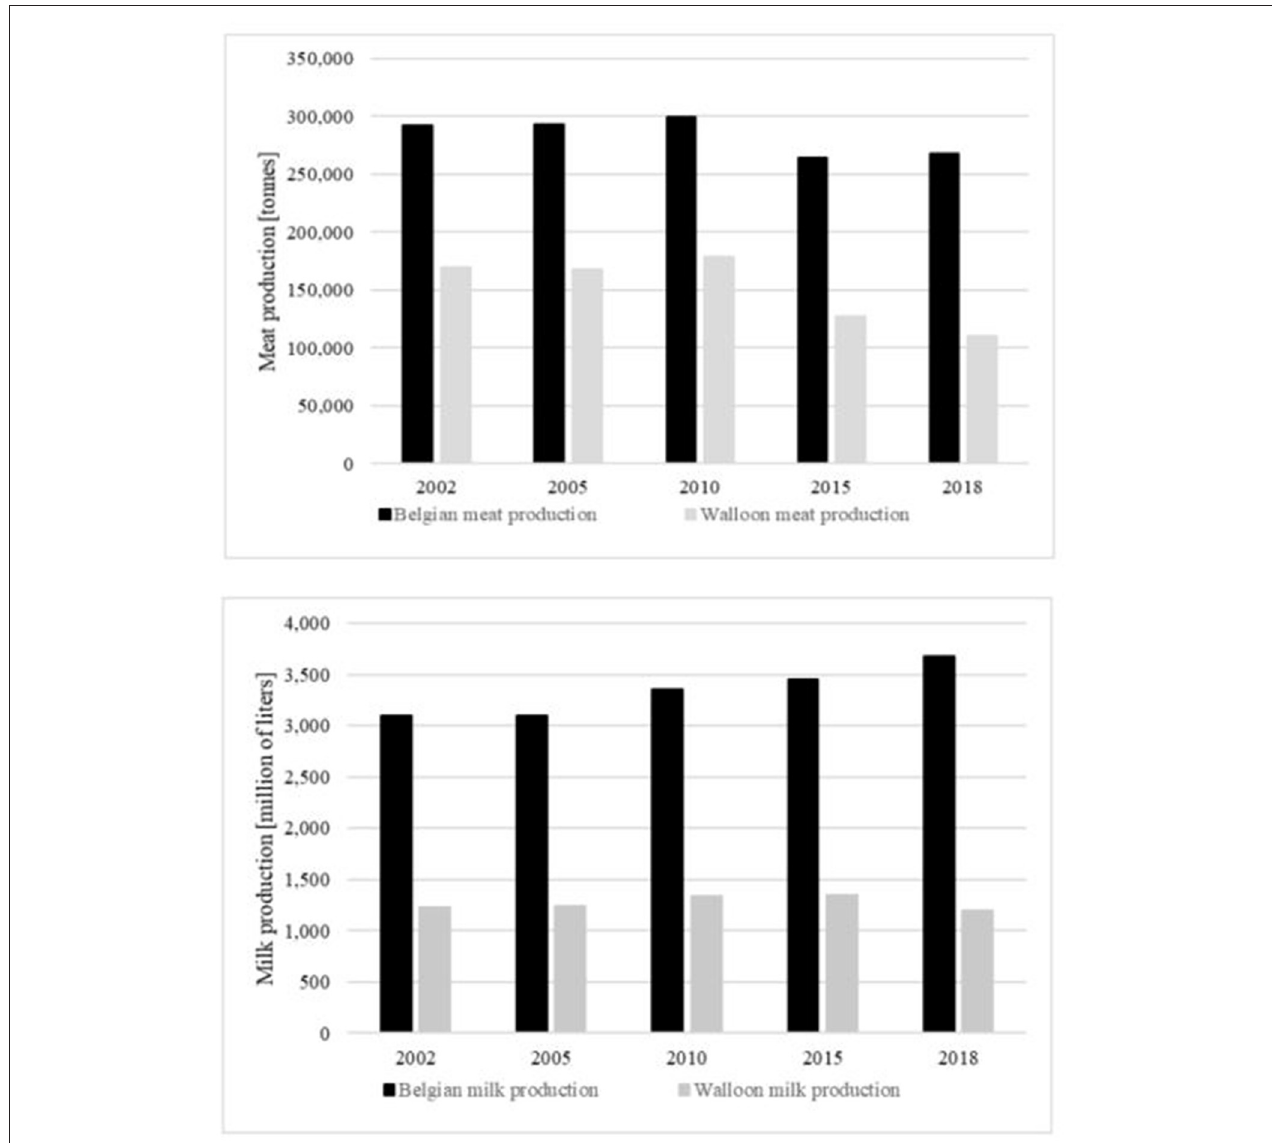
FIGURE 2 | Milk and meat production in Belgium and Wallonia (SPW). The most common breeds within the Walloon dairy sector are the Freisen-Holstein (89%), the Bleues mixtes (4%), the Montbéliardes (2%), the Rouge Pie de l’Est (1%), the Normandes (1%) and other breeds (4%) (La Spina, 2017), while the dominant breed in the beef sector is the double-muscled Belgian Blue (83%) followed by French breeds such as the Limousine (6%) , the Blonde d’Aquitaine (3%) and Charolaise (2%) (Buron et al., 2014). Dairy production is concentrated in the province of Liège ( Région herbagère Liégeoise and Haute Ardenne ), while beef production is mainly located in the South of Wallonia, particularly in the province of Luxembourg (SPW,